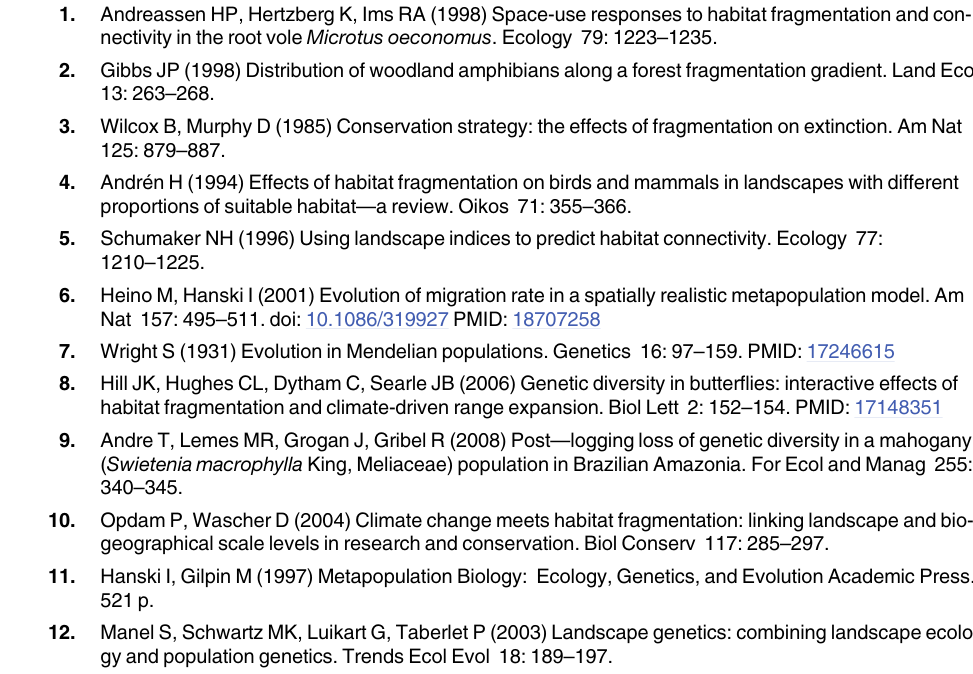
/1 — F between 33 study cells included in ST ST